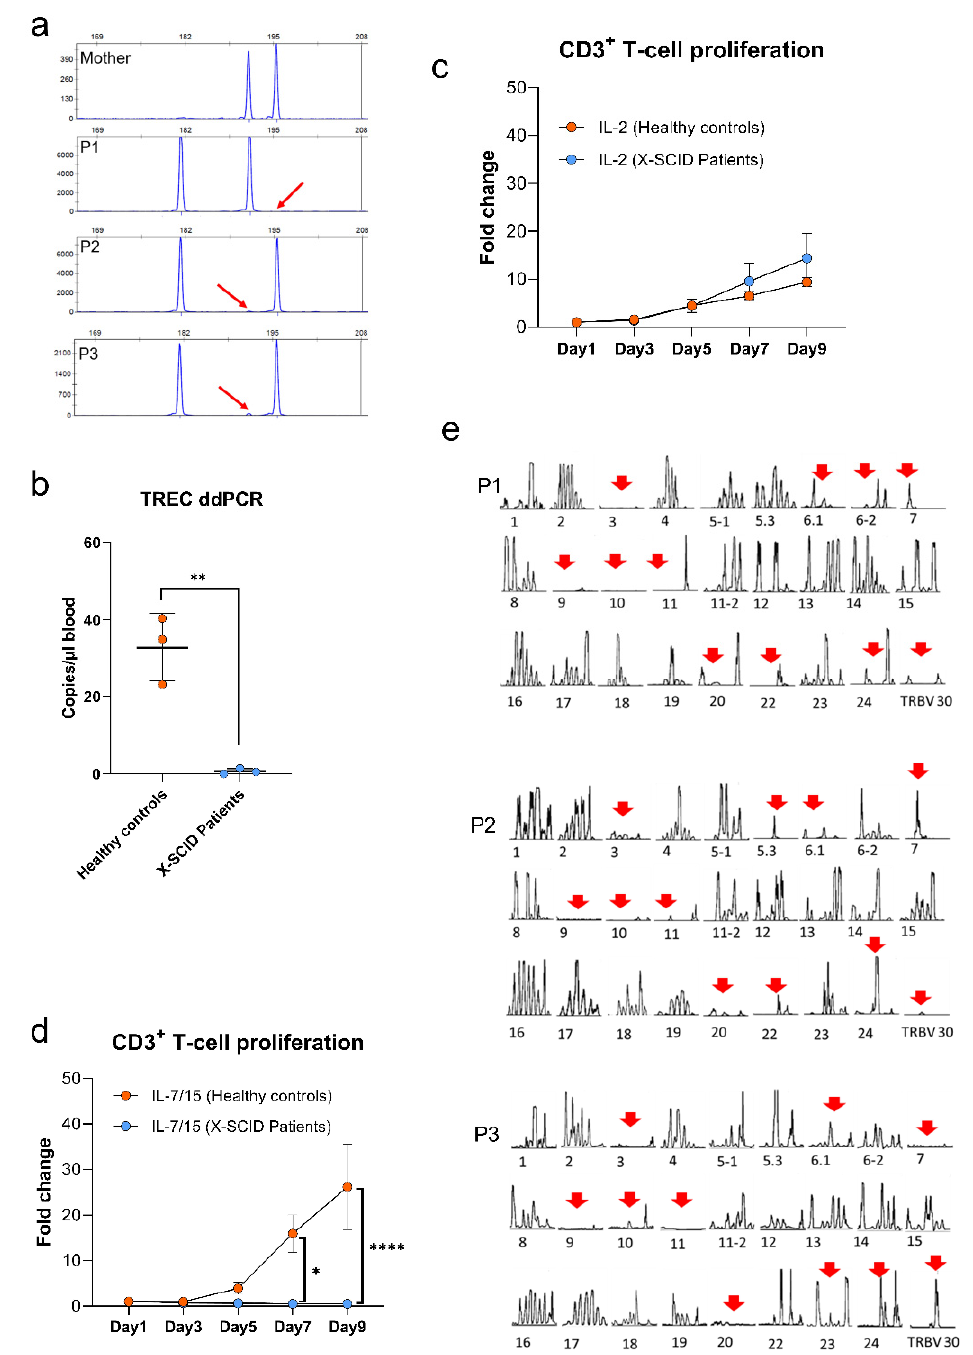
Figure 4. Maternal engraftment ( a ): Circulating maternal engrafted T cells were excluded due to dissimilar peaks. Typical STR profile with allele designation for genomic DNA extracted from CD3 + T cells of mother and three patients. The horizontal axis represents the values of fragment in base pairs and the vertical axis represents the values in relative fluorescent units (RFU). Amount of TREC ( b ) per µL of blood was determined by ddPCR. The amount of TREC (<10/µL blood) of three patients was much lower than healthy controls ( n = 3) with a similar age (** p < 0.01). CD3 + T cells proliferation ( c , d ) response to IL-2 (50 units/mL), or IL-7 (10 ng/mL) and IL-15 (5 ng/mL), as well as TransAct (* p < 0.05, **** p < 0.0001). T-cell receptor repertoire analysis and CDR3 spectratyping ( e ): TCR β